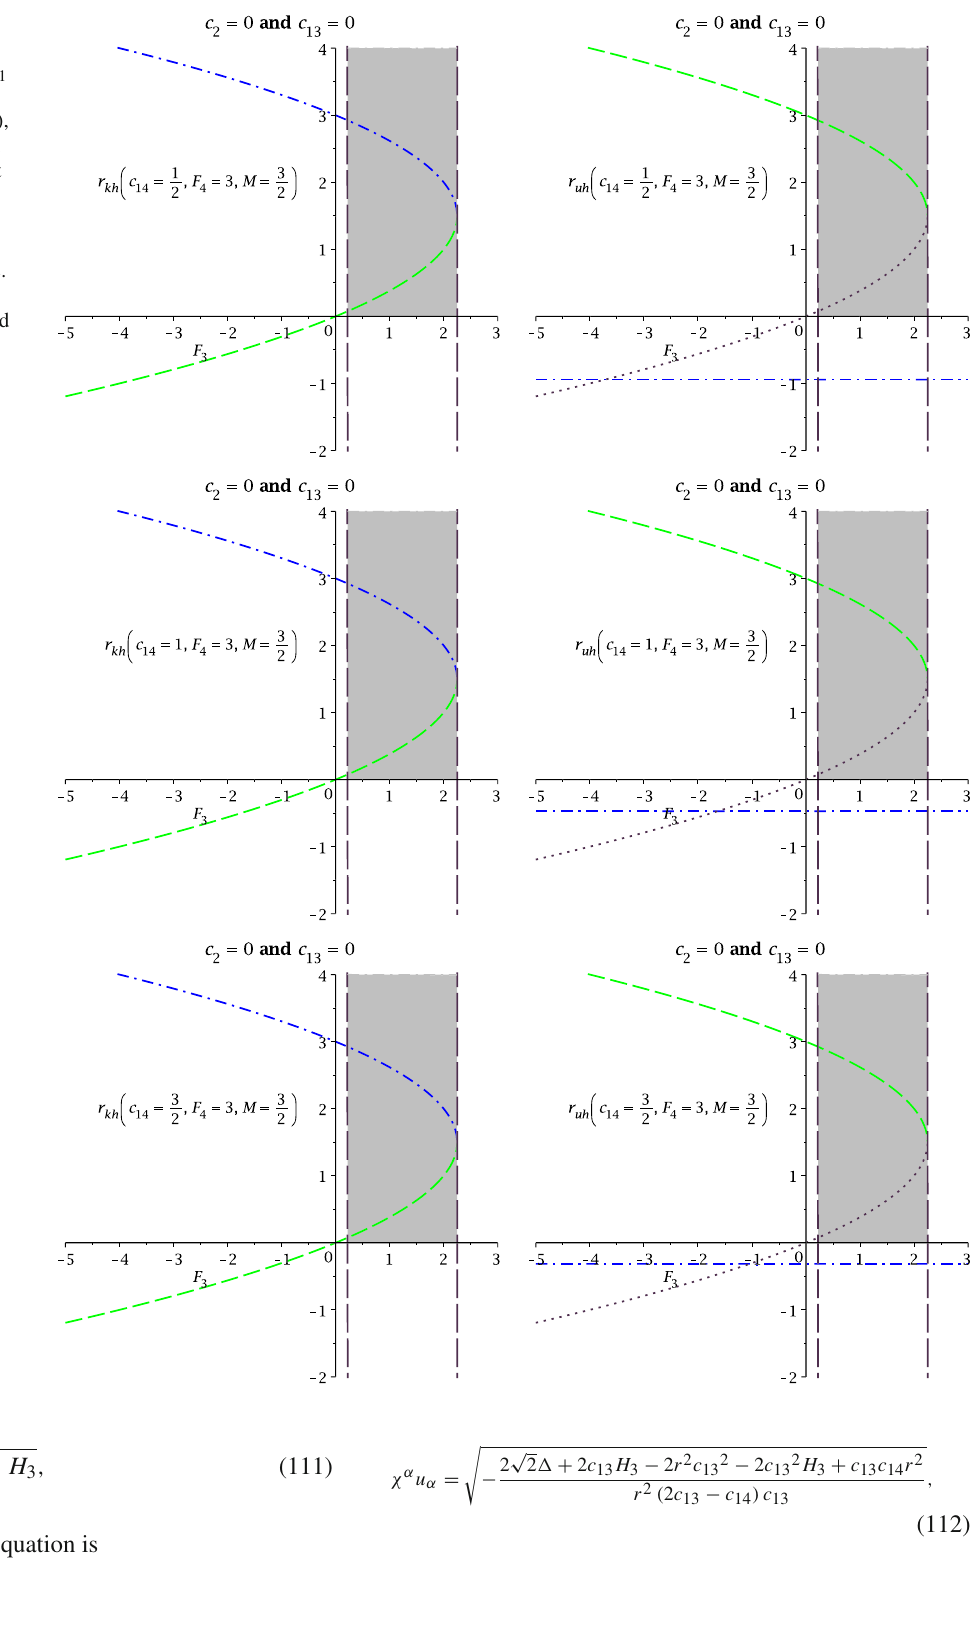
Fig. 4 These figures show the Killing and universal radii for the Case D where we have: r kh 1 or r uh 1 (blue dot-dashed line), r kh 2 or r uh 2 (green dashed line), r kh 3 or r uh 3 (black dotted line). The violet long-dashed straight lines represent the inferior and superior limits of F 3 . The horizons that are not displayed in these figures are